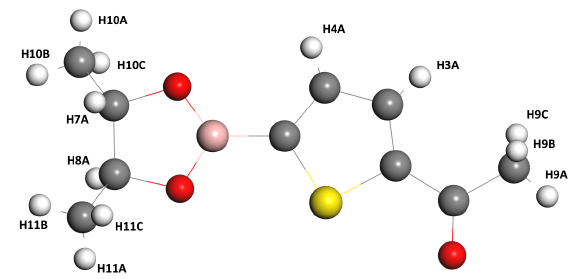
Figure 3. Hydrogen atoms of the C 10 H 13 BO 3 S